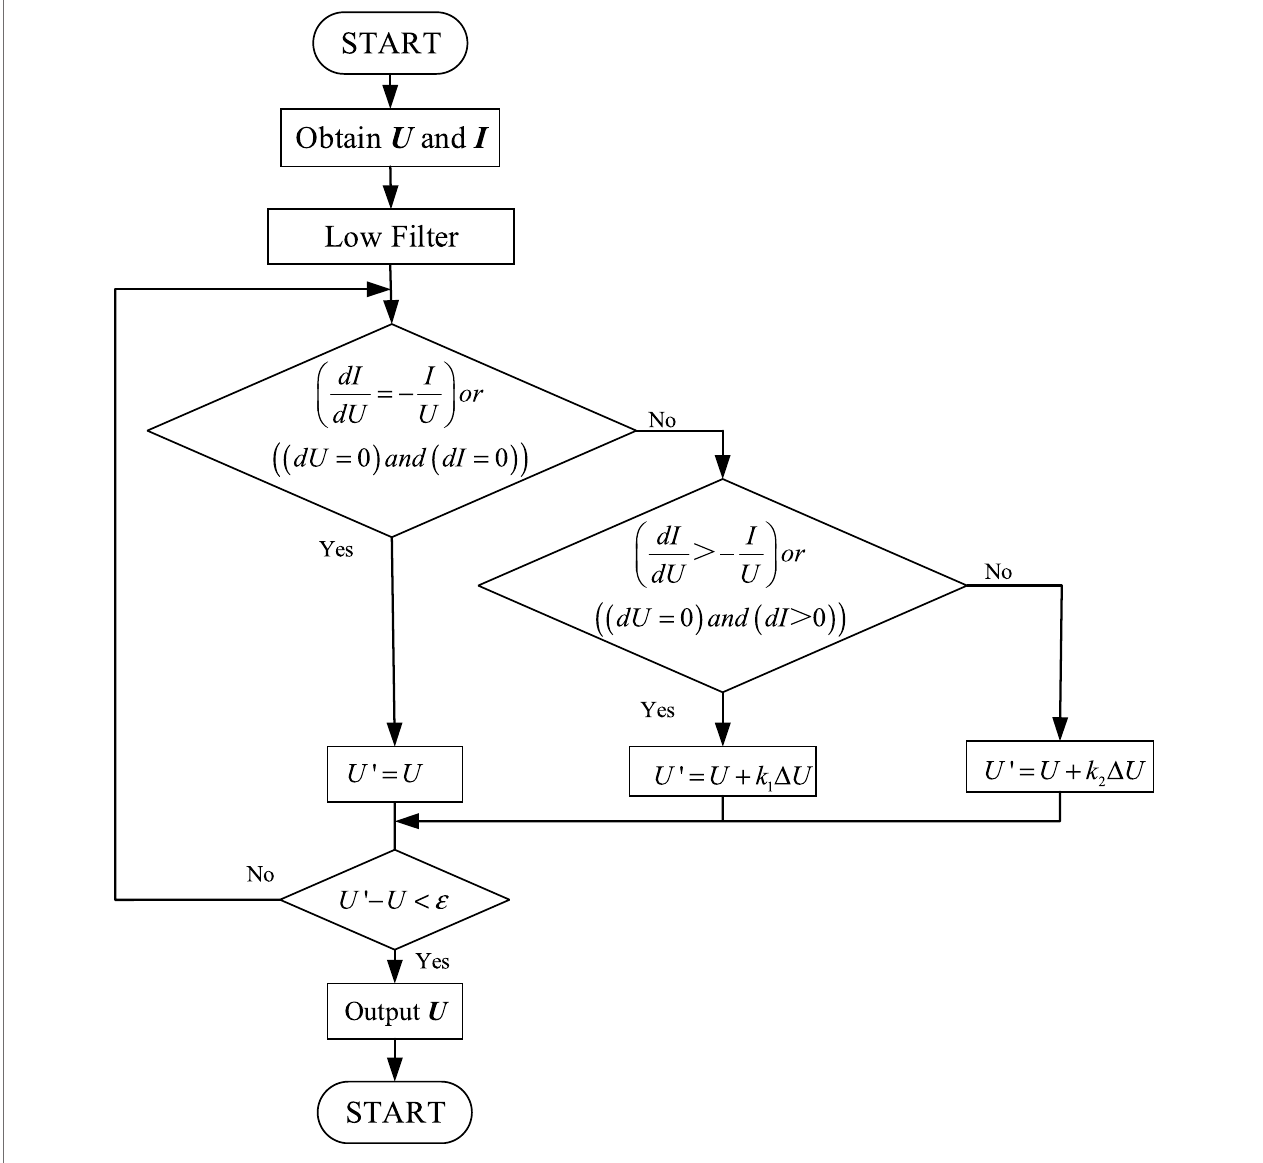
FIGURE 5 | Flowchart of Adaptive variable step conductance increment